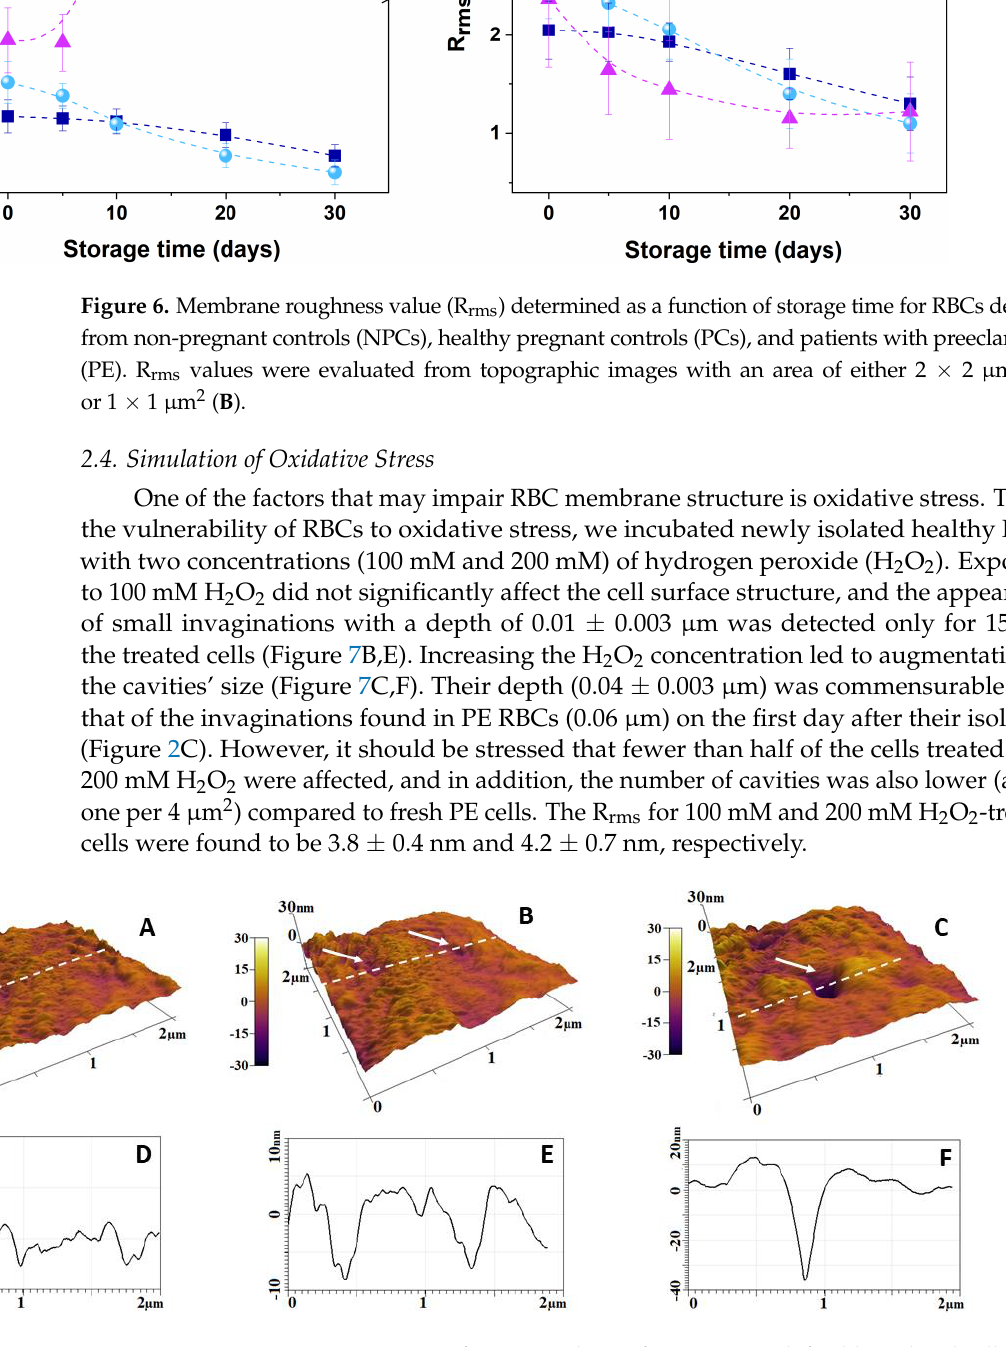
Figure 7. Representative 3D images of RBC membrane for non-treated, freshly isolated cells from healthy donors ( A ) and cells treated with 100 mM ( B ) and 200 mM ( C ) H 2 O 2 . The respective cross- sectional profiles defined by the dashed line at each panel are presented in panels ( D – F ). Arrows in panels B and C indicate the appearance of invaginations after treatment with H 2 O 2 .